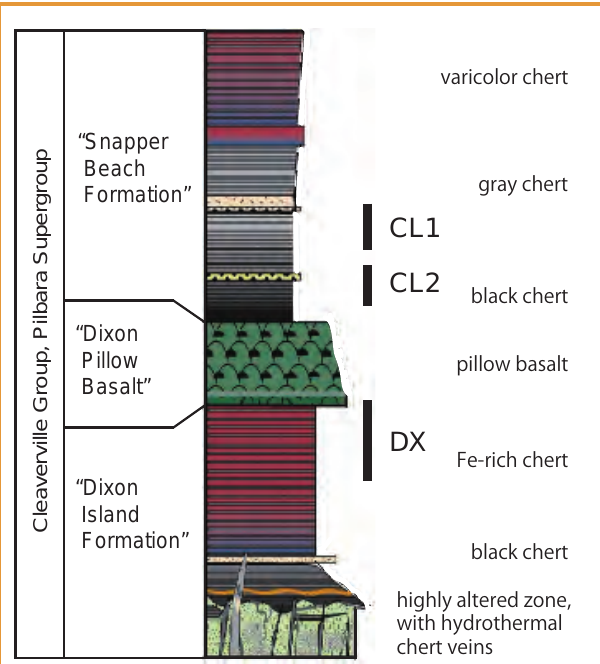
Figure 2. Stratigraphic column of the 3.2-Ga Cleaverville Group of the Pilbara Supergroup. Names of the Snapper Beach and Dixon Island Formations are provisional. Modified after Kiyokawa et al., 2006.